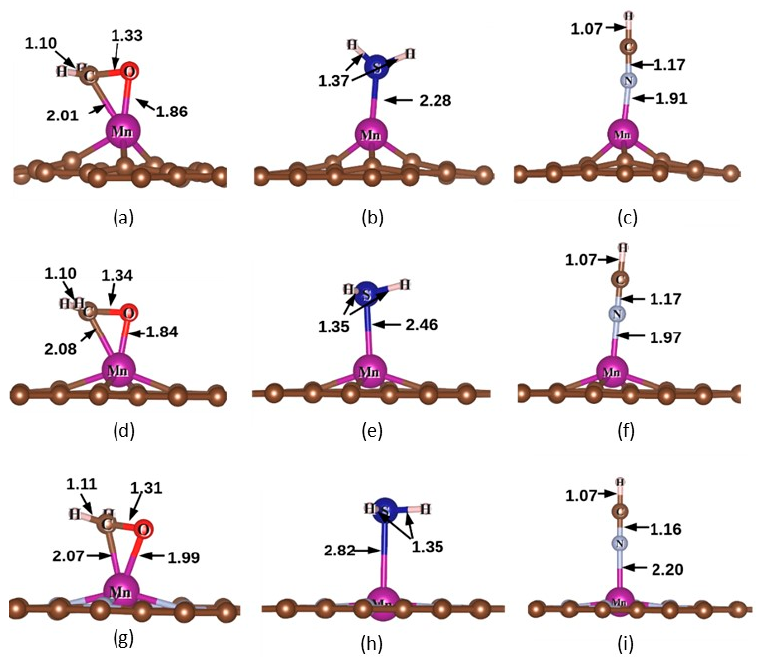
Figure 2. The optimized structures of ( a ) CH 2 O/MnSV-GN, ( b ) H 2 S/MnSV-GN, ( c ) HCN/MnSV-GN, ( e ) CH 2 O/MnDV-GN, ( f ) H 2 S/MnDV-GN, ( g ) HCN/MnDV-GN, ( h ) CH 2 O/MnN 4 -GN, ( i ) H 2 S/ MnN 4 -GN and ( j ) HCN/ MnN 4 -GN. The selected bond distance is expressed in